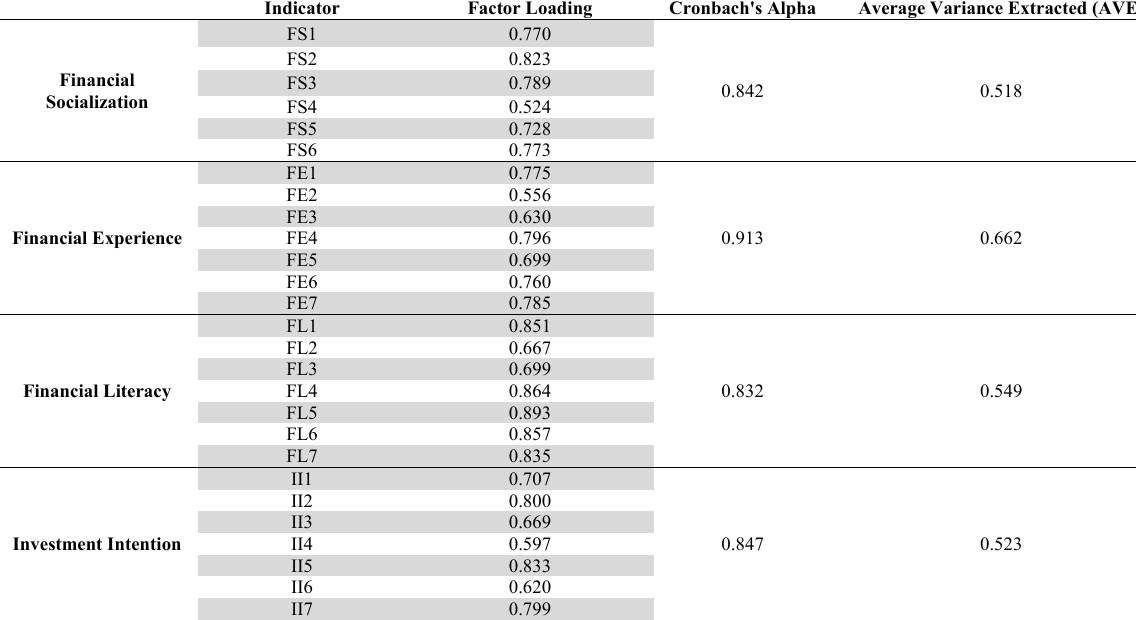
Convergent Reliability Results